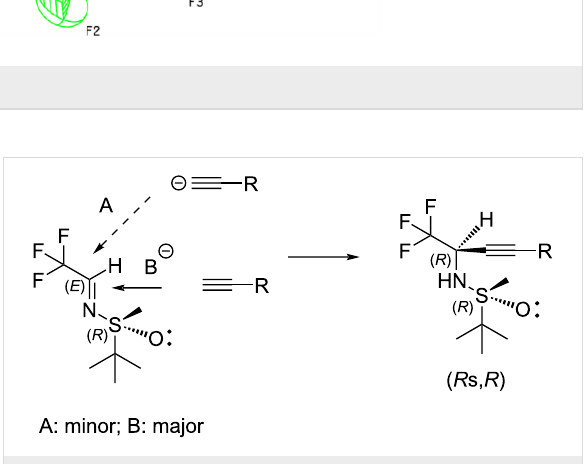
Figure 3: Mode of nucleophilic attacks A and